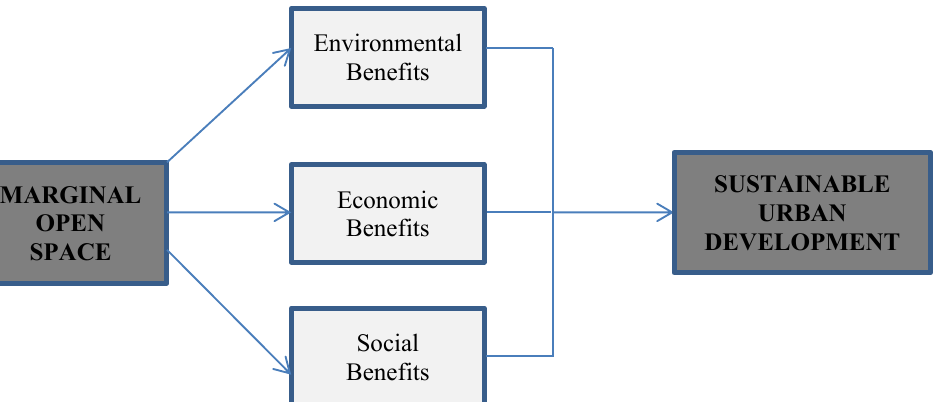
Figure 1 . Framework for benefits of marginal open space and sustainable urban development.